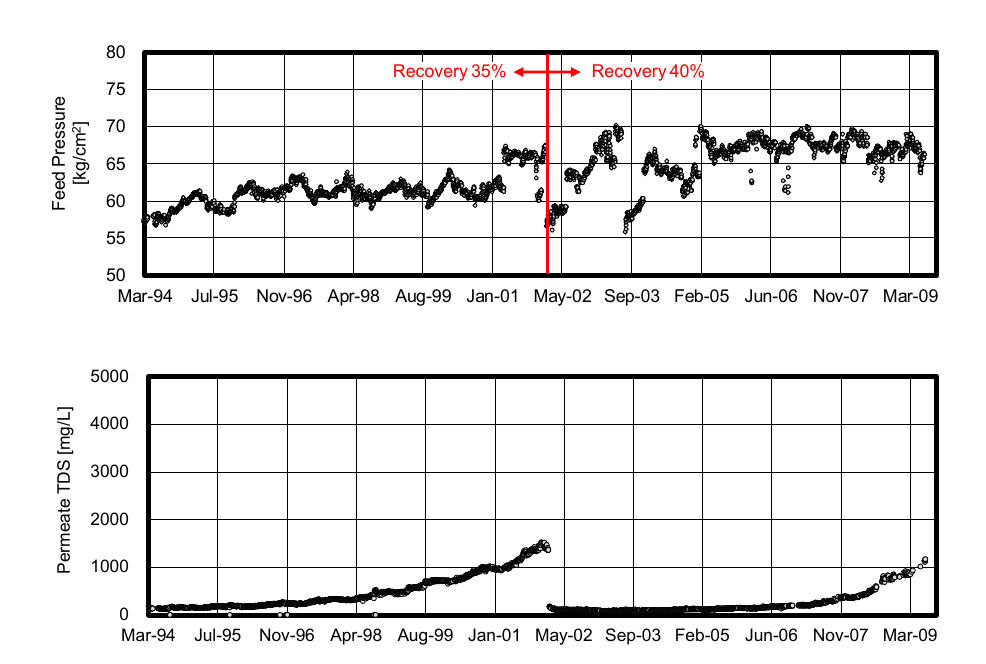
Figure 17. Seawater RO desalination in Jeddah 1 phase II plant. Data from [94].